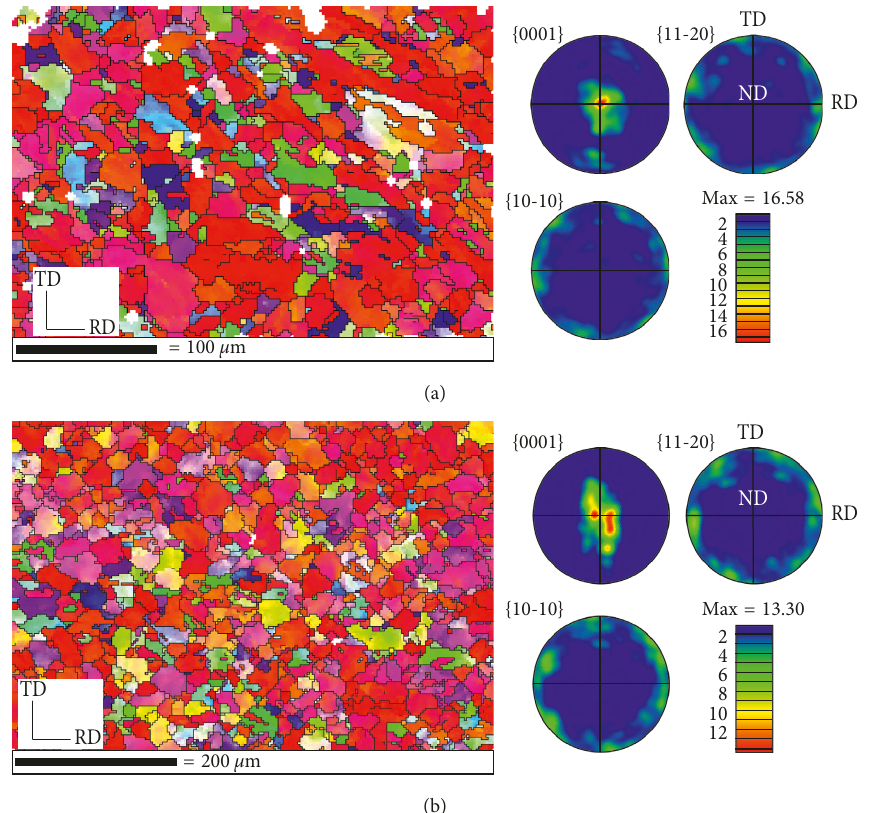
Figure 6: EBSD inverse pole figure (IPF) maps (left) and pole figures (right) showing microstructure and texture in RD-TD plane of the (a) ND0ED 0 and (b) ND90ED 0 pure magnesium samples after plane strain compression. The color legend is the same as in Figure